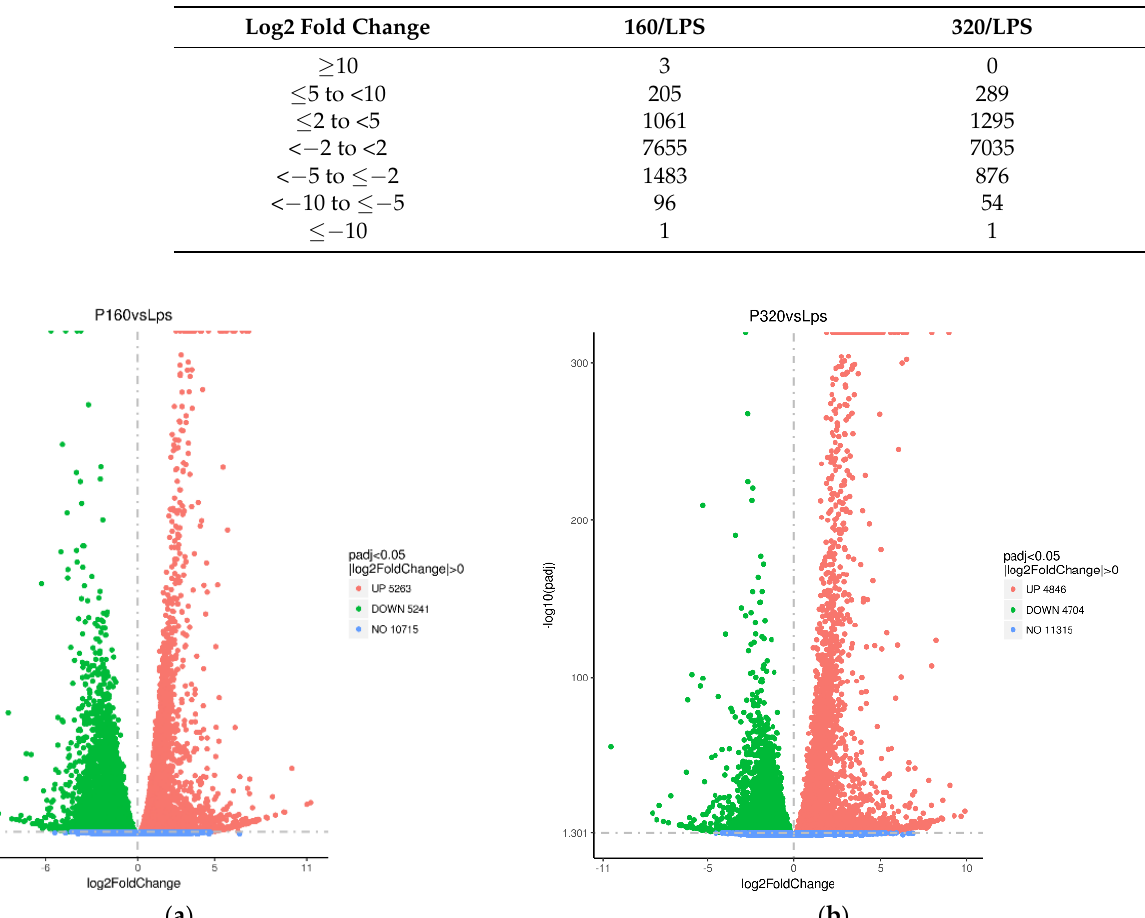
Table 2. The statistical table of differentially expressed genes.